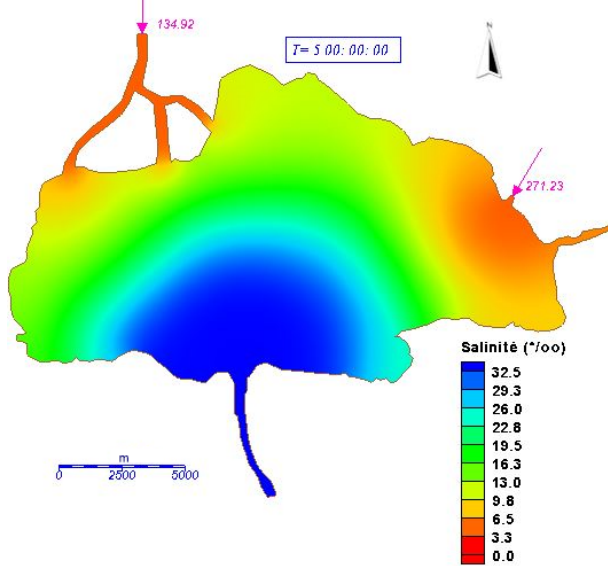
Figure 8. Spatio-temporal variation in salinity during a flood period after 5d of